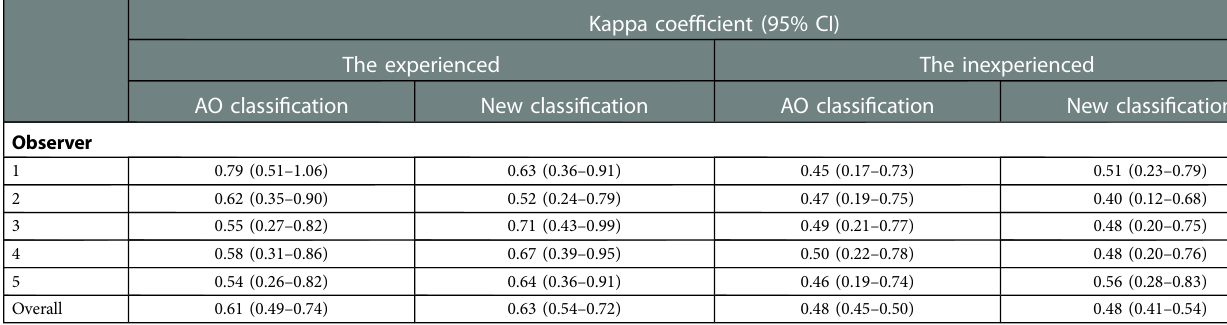
TABLE 4 Reliability between observer and reference